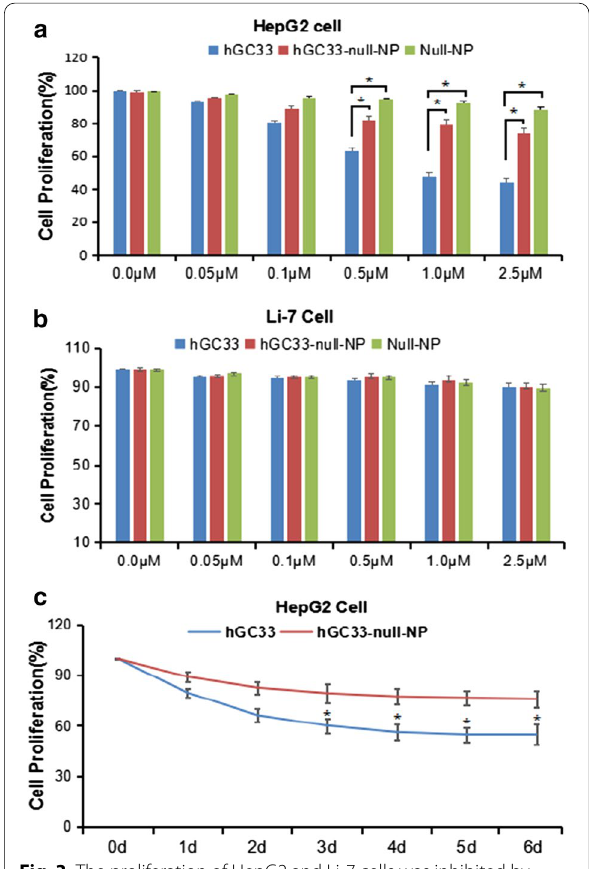
Fig. 3 The proliferation of HepG2 and Li-7 cells was inhibited by hGC33, null-NP, and hGC33-null-NP. a Cell proliferation test was performed on GPC3-positive HepG2 cells treated with hGC33, null-NP or hGC33-null-NP; b cell proliferation tests were conducted on GPC3 negative Li-7 cells treated with hGC33, null-NP, and hGC33-null-NP. The cells were incubated with 0–2.5 μM hGC33, null-NP, or hGC33-null-NP for 1 day. The proliferation of the cells was measured with MTT method and standardized as untreated cells. All values represent the mean SD. Compared with the control group (0 μM) ± without antibody treatment, * P < 0.01; c the representative results of response of HepG2 to hGC33, null-NP, and hGC33-null-NP in hGC33 treatment (1.0